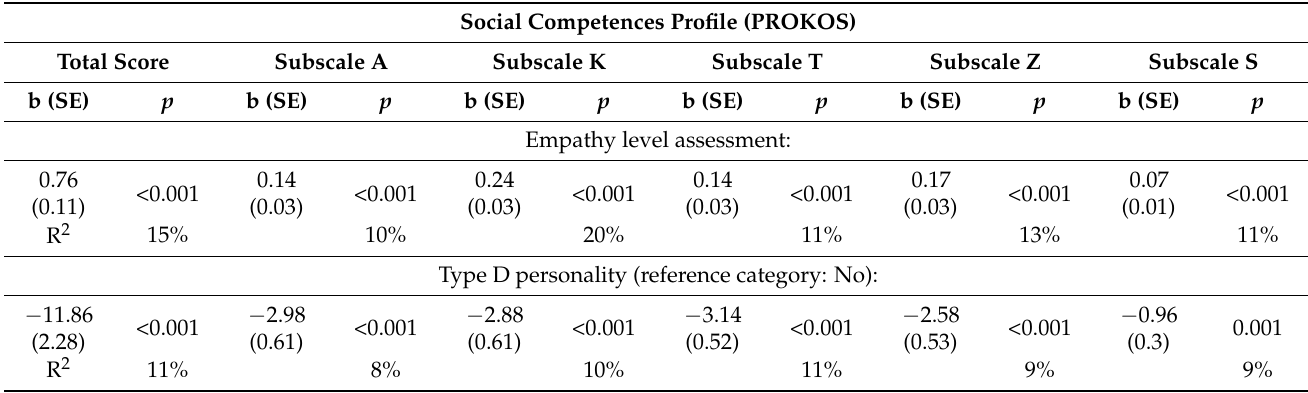
Table 2. Relationship between empathy level assessment, type D personality and social